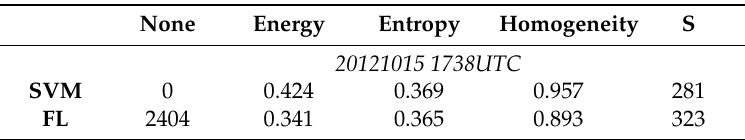
Table 3. Quantitative indices for classification results obtained by the SVM and FL HCAs. Scores are referred to the C-band RHI shown in Figure 5.